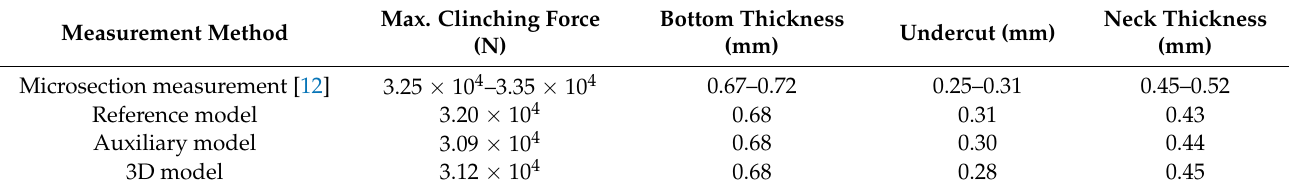
Table 3. Results of the numerical analyses compared to the force and microsection measurement in ref. [12] (five specimens, no measurement uncertainty